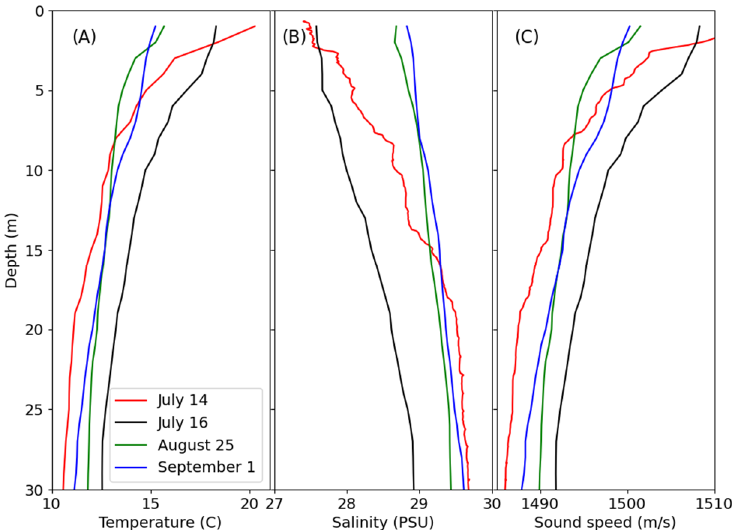
Figure 8. Temperature ( A ) and salinity ( B ) profiles measured during the four experimental periods in 2021. The profiles from 14 July and 16 and 25 August were taken in a shallow-water setting, and that on 1 September was taken in the upper 30 m of the deep-water setting. Sound-speed profiles ( C ) were calculated using the method of Leroy et al. [57].